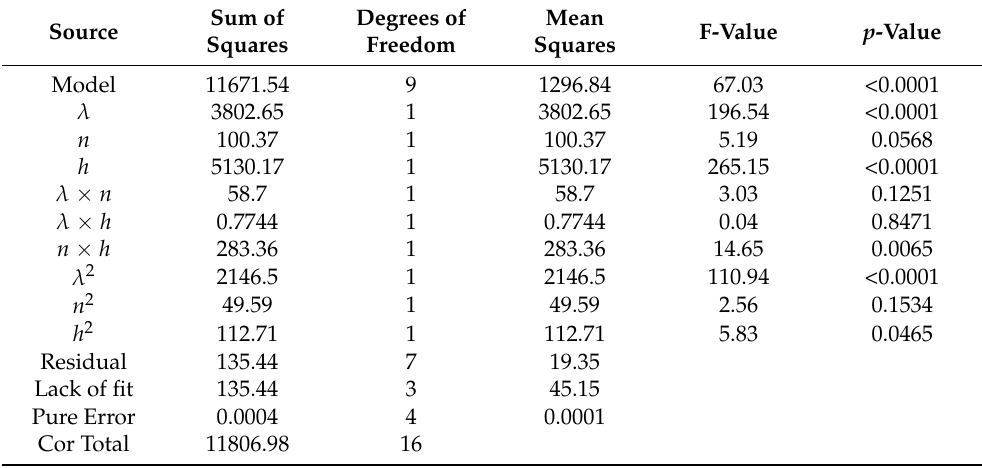
Table 6. ANOVA results of milling